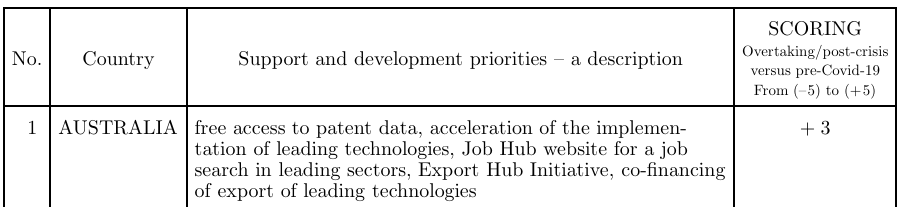
SCORING Overtaking/post-crisis No. Country Support and development priorities – a description versus pre-Covid-19 From (–5) to